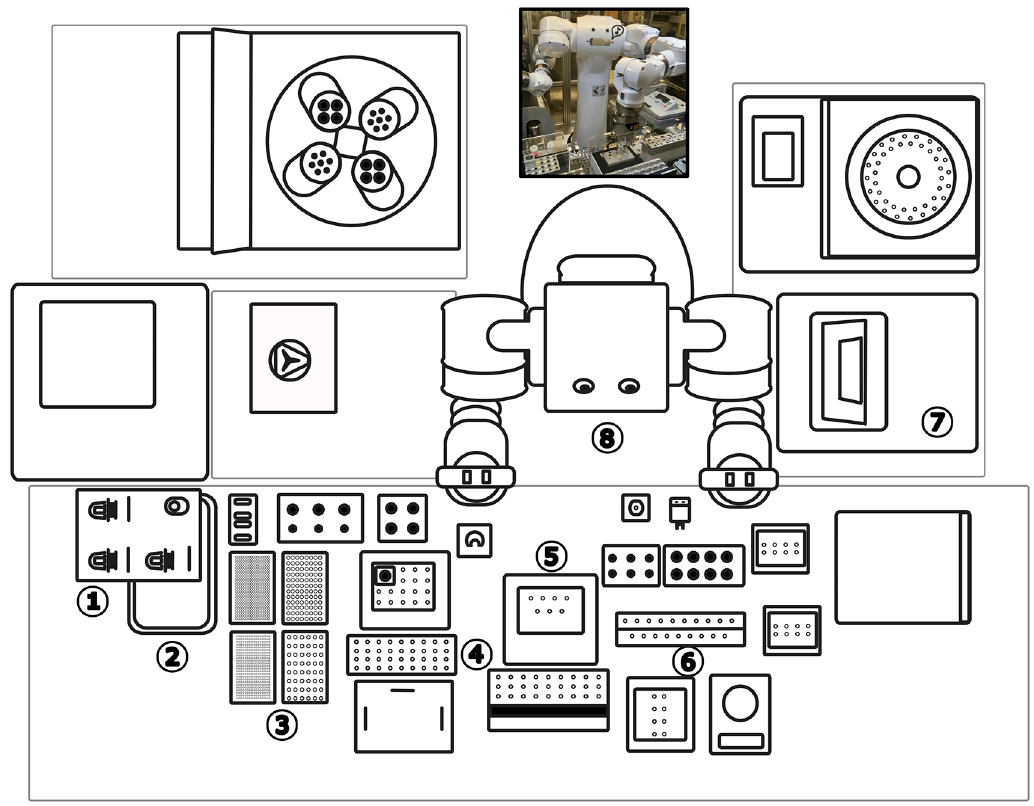
Figure1.SchematicoverheadviewoftheLabDroid ’ sworkspacelayout. 1)micro-pipettorstation2)wastepipette tip pan 3) pipette tips 4) reagents/tube rack 5) 4 ° C cool block 6) sample tube rack/mixing station 7) high speed centrifuge 8)